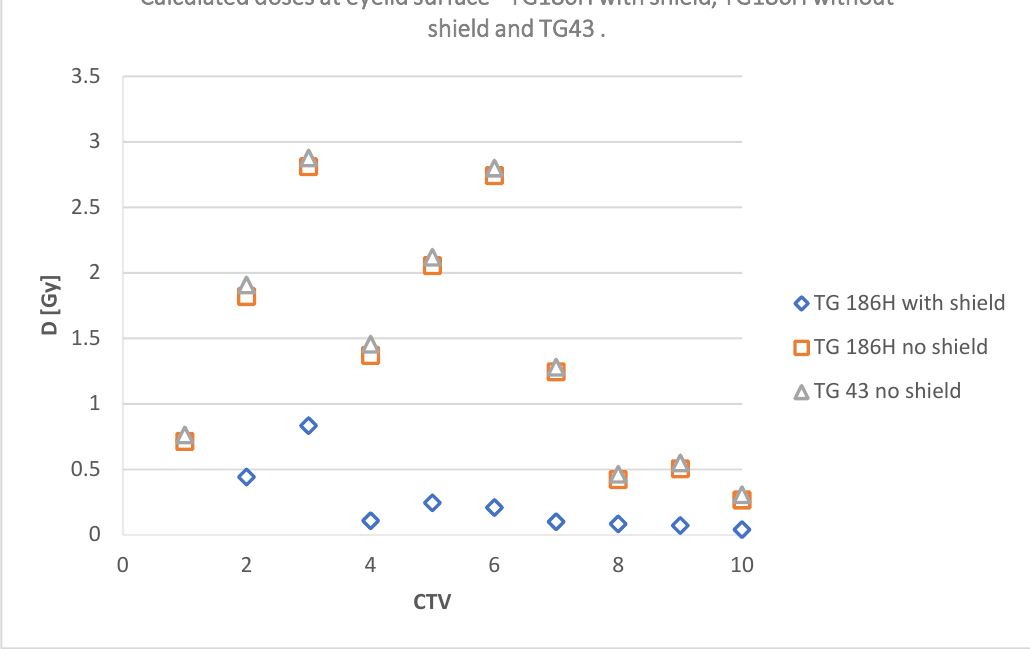
Table 4. Dose values measured and calculated at a point on the eyelid surface. Without Lead Shielding With Lead Shielding PLAN